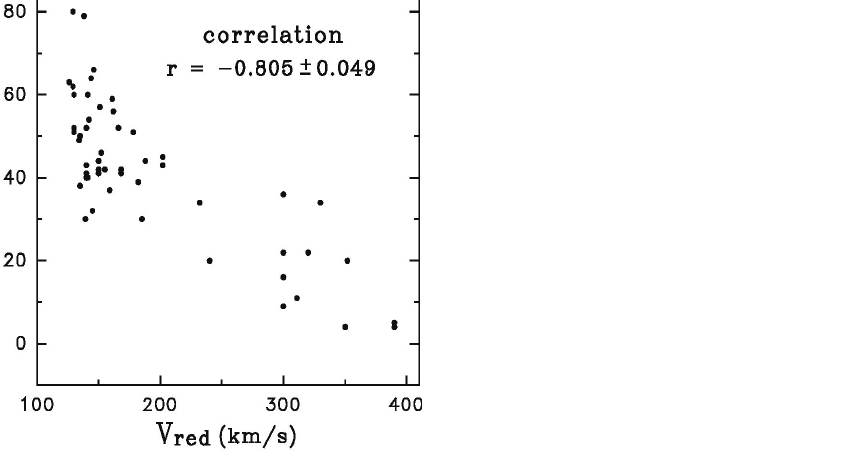
Figure 5. Dependence between the parameters V bis (H β ) and V red (He I λ 5876) in the spectra of HD259431. r is the correlation